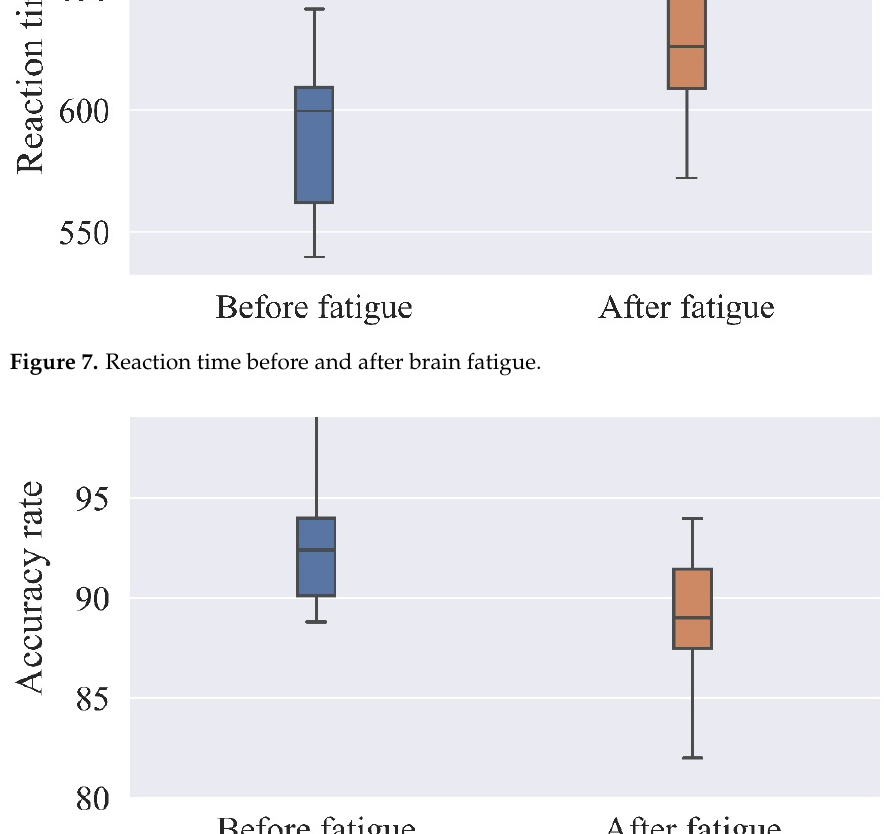
Figure 8. Accuracy rate before and after brain fatigue. Table 6. Paired samples t -test results for accuracy rate.